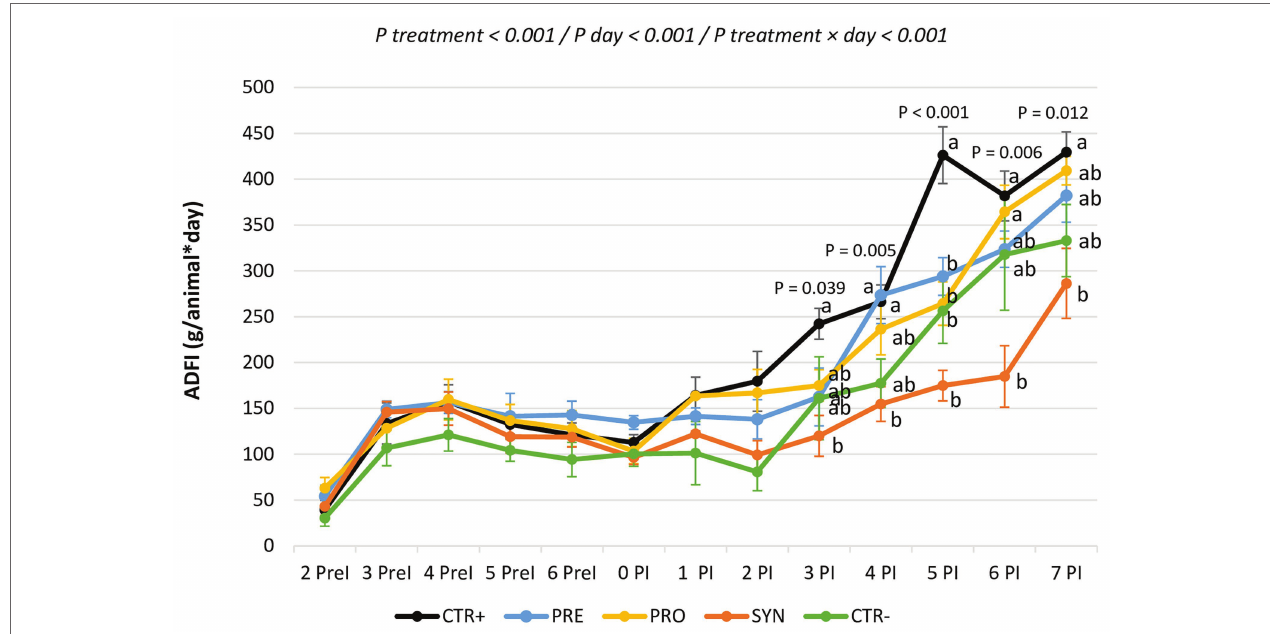
FIGURE 1 | Evolution of feed consumption for the experimental groups during the entire experimental period. CTR+: non-inoculated animals receiving placebo; PRO: inoculated animals receiving the probiotics; PRE: inoculated animals receiving the prebiotic; SYN − : inoculated animals receiving the synbiotic; CTR − : inoculated animals receiving placebo. N = 6 for all groups except for non-challenged animals ( N = 8). a and b indicate statistically significant differences between groups. Bars correspond to the standard error. ADFI, average daily feed intake; PreI, pre-inoculation; PI, post-inoculation.